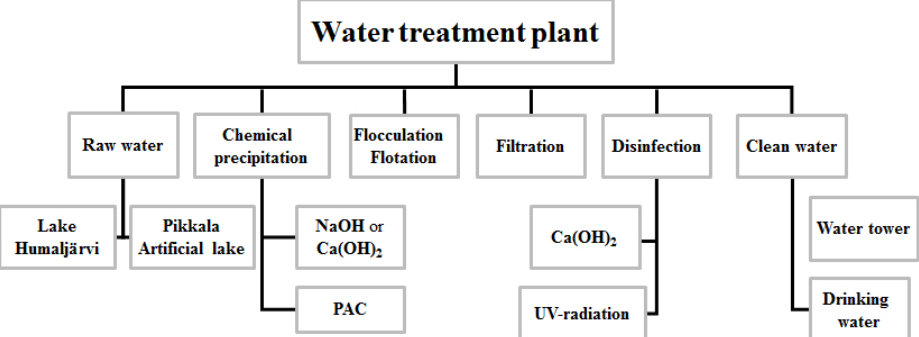
Figure 1. Processing stages of the Finnsugar Ltd. water treatment